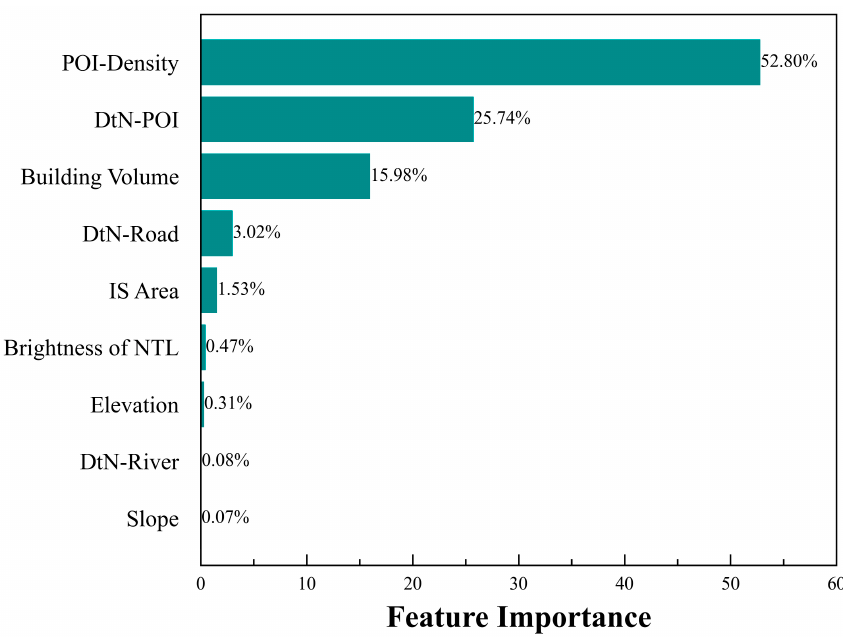
Figure 10. Permutation-based feature importance results of the GXLS-Stacking model. DMSP-OLS nighttime light data have been widely used to assess the spatial distribu- tion of populations and have shown a strong correlation [7,46,63–65]. We used NPP-VIIRS nighttime light data with better quality and higher spatial resolution than DMSP-OLS [68], but, surprisingly, the importance of the brightness of NTL feature is only 0.47%. The basic logic of using the brightness of NTL to distribute populations is that areas with bright lights at night usually have a large population [64]. However, the blooming effect is inherent to NTL and indicates that the peri-urban areas are illuminated by city lights [93]. Therefore, NTL within a small land area inside a city can brighten a large surrounding area [94]. In addition, although NPP-VIIRS does not have the saturation effect of DMSP-OLS and has a higher spatial resolution (i.e., 500 m), it is still not sufficient to reflect the population density in a small geographic area within the city due to the abovementioned